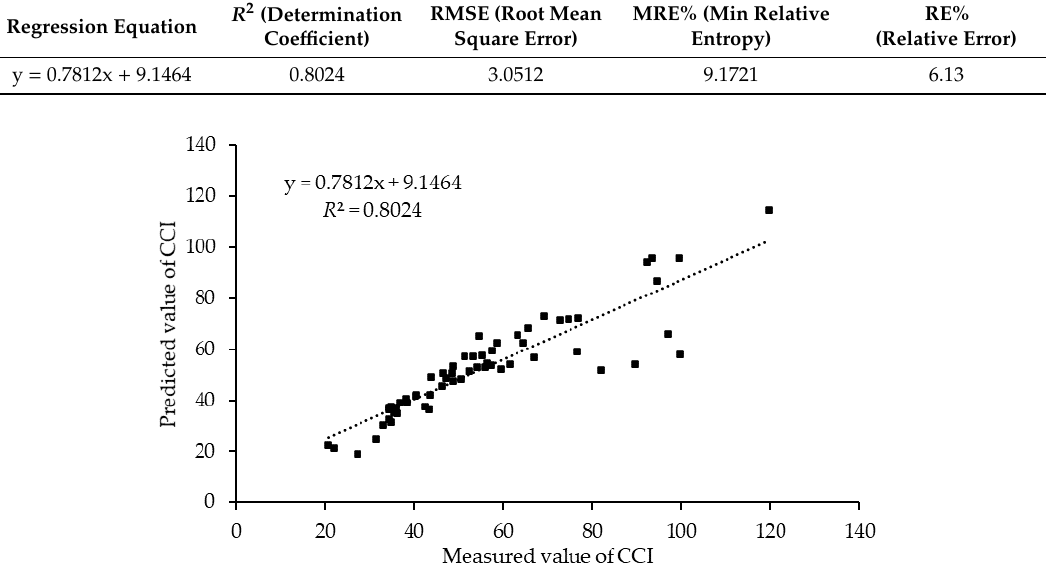
Table 4. The fit evaluation indicators of the measured values (x) and predicted values (y).